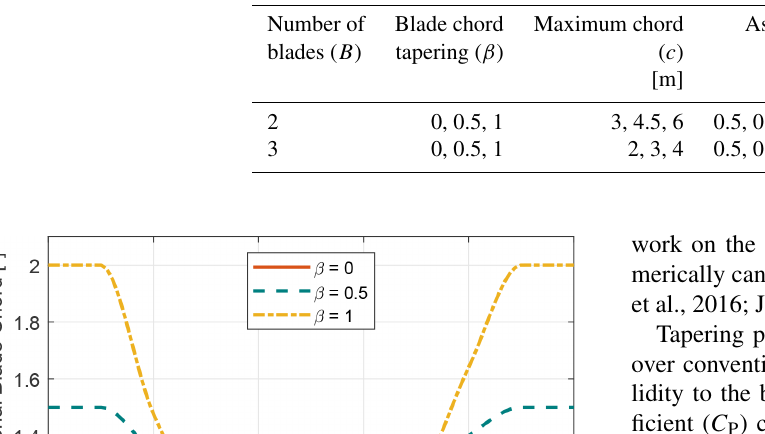
Table 1. Rotor design candidate summary.